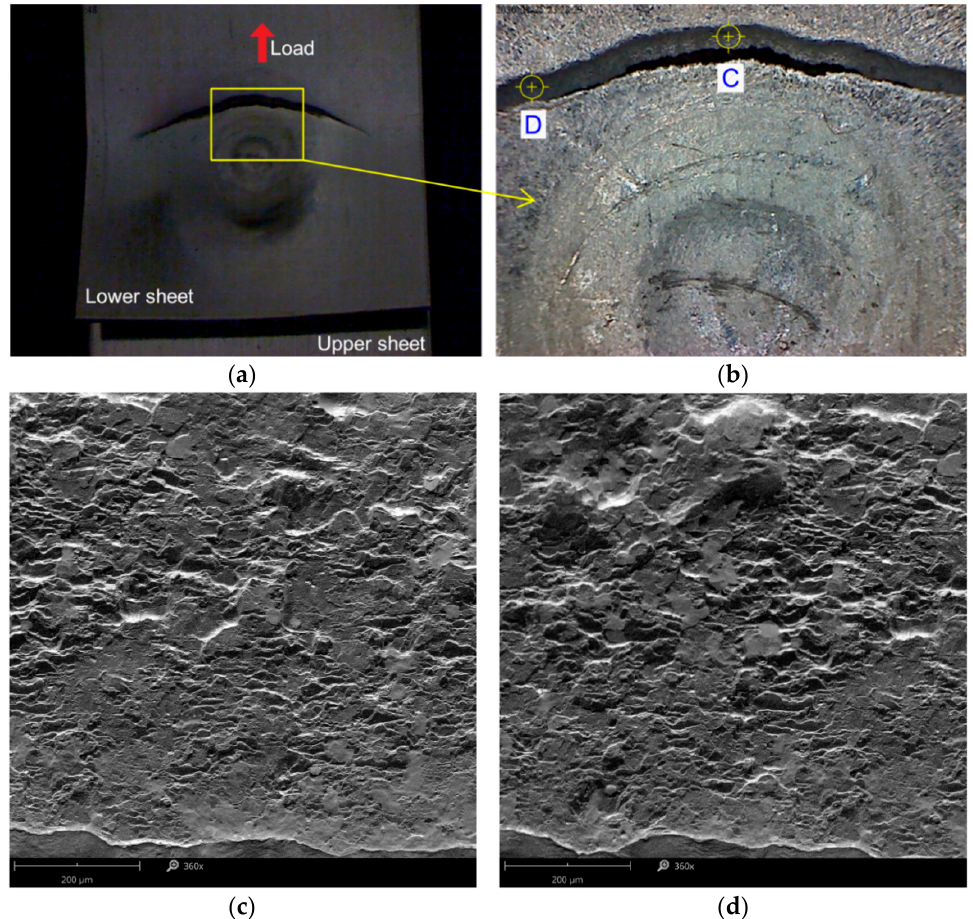
Figure 12. Fracture of the lower sheet which has failed in tensile fracture mode (experiment E2): ( a , b ) macroscopic view of the fracture, ( c , d ) SEM views of the edge of the fracture in areas C and D indicated in ( b ).